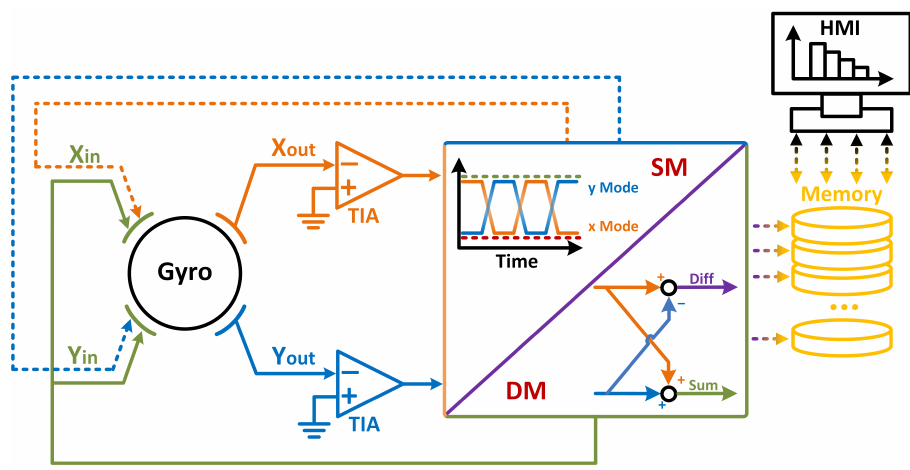
Figure 5. Hybrid gyro interface system with single-mode and dual-mode.